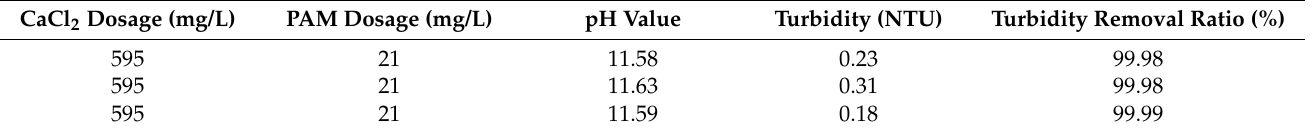
Table 5. Verification of values predicted by the quadratic response surface model. CaCl 2 Dosage (mg/L) PAM Dosage